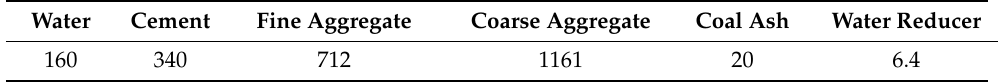
Table 1. Concrete mixture ratio (kg/m 3 ).